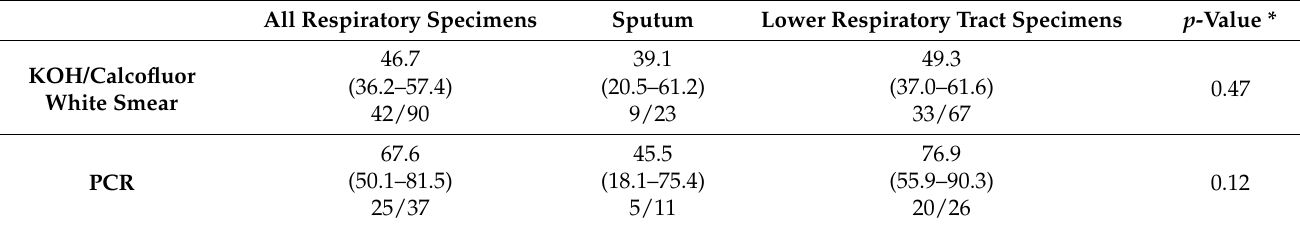
Table 4. Sensitivity of KOH smear and PCR in respiratory specimens (sensitivity shown as percentage, 95% confidence intervals shown in